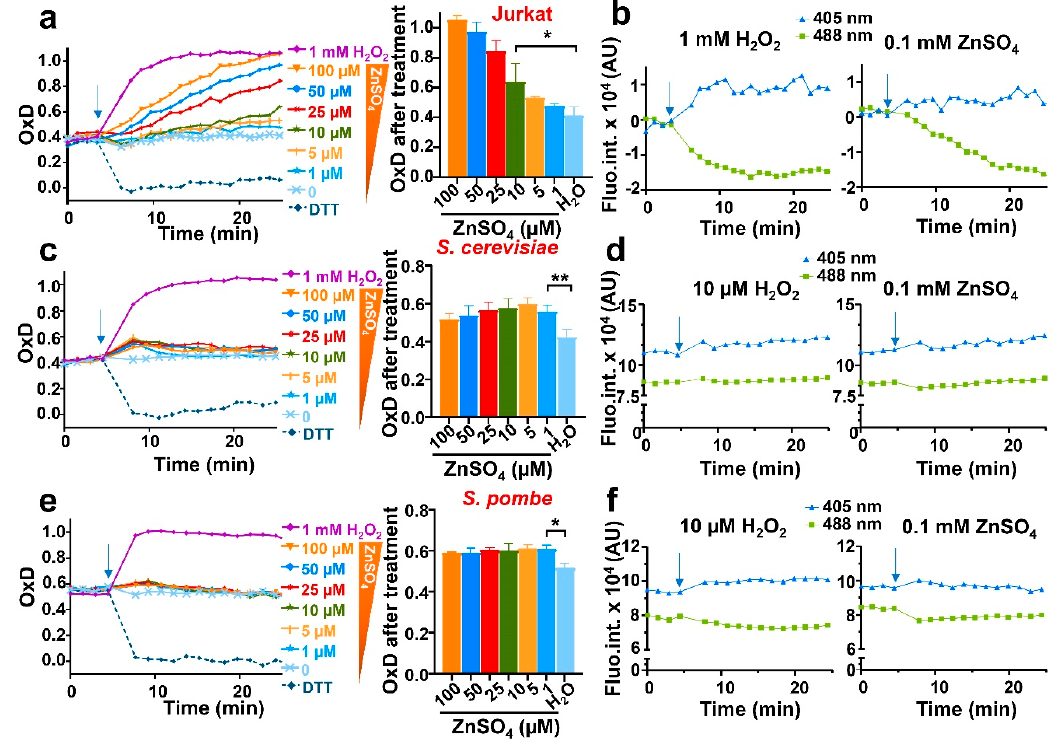
Figure 3. The addition of extracellular zinc causes intracellular bursts of H 2 O 2 in the three eukaryotic models. Cell suspensions of Jurkat T cells ( a , b ), BY4741 ( S. cerevisiae ) ( c , d ), or HM123 ( S. pombe ) ( e , f ) expressing roGFP2-Tpx1.C169S were treated with 1 mM of H 2 O 2 (as a control) or with the indicated concentrations of ZnSO 4 , ranging from 1 to 100 µ M. Probe oxidation was determined as in Figure 2. ( a ) Jurkat experiments were performed as previously described at 37 ◦ C with 100 rpm shaking. The middle panel (bar graph) represents the OxD at min 25. ( b ) Graphs showing the time-dependent (X-axis) emission fluorescence (Y-axis, fluorescence arbitrary units, AU) of the reporter in Jurkat upon excitation at 405 or 488 nm. ( c – f ) Yeast experiments were performed at 30 ◦ C and 700 rpm shaking. The middle panel (bar graph) represents the OxD at the first time point after treatment. ( d , f ) Graphs showing the time-dependent (X-axis) emission fluorescence (Y-axis, fluorescence arbitrary units, AU) of the reporter in yeasts upon excitation at 405 or 488 nm. In all graphs, the time of addition is indicated with arrows. Statistical significance was calculated with a ratio paired Student’s t -test between pointed-out samples with p -values of 0.05 (*) and 0.01 (**). For each strain, average data from three biological replicates are shown, with error bars (S.D.) of left panels ( a , c , e ) displayed in Figure